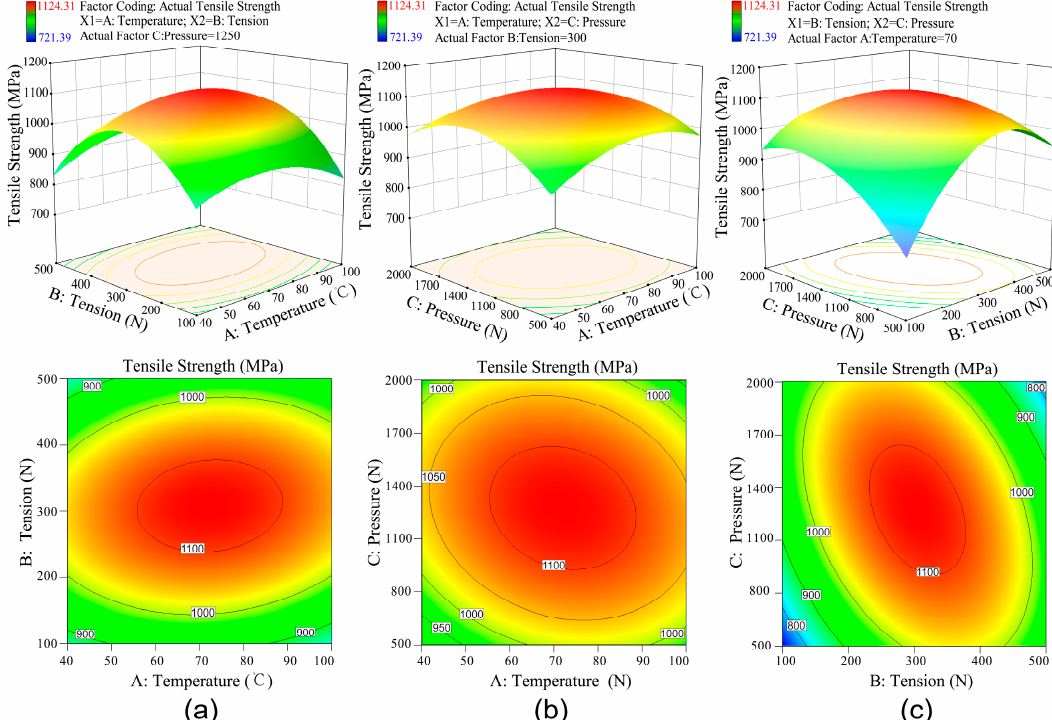
Figure 6. The response surface and contour lines map of process parameters on the tensile strength. ( a ) Coupling e ff ect of temperature and tension; ( b ) Coupling e ff ect of temperature and pressure; ( c ) Coupling e ff ect of tension and